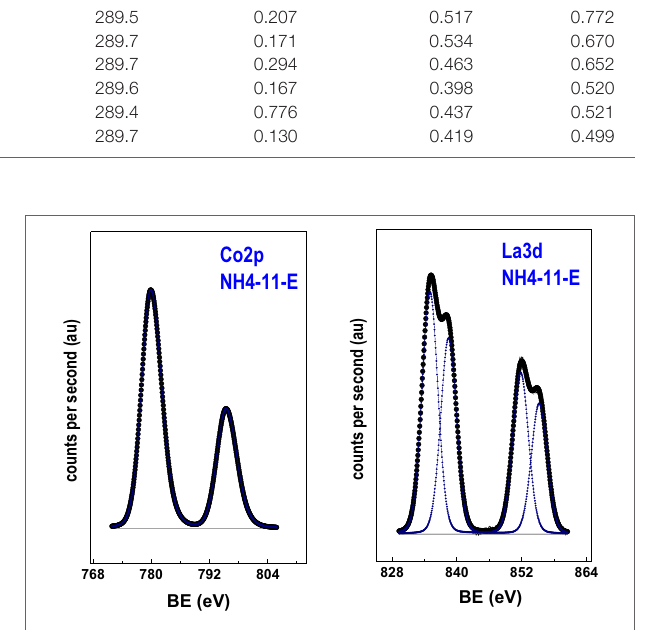
Table 3 | Binding energies of La3d5/2, Co2p3/2, O1s, and C1s core levels and Co/La, Co/(Co + La), CO 32 − /La surface ratios for catalysts after reaction. catalyst